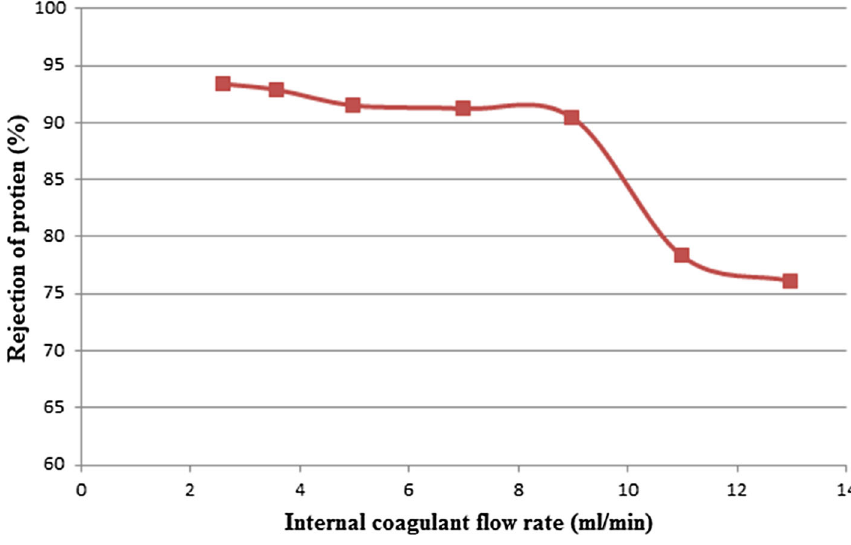
Fig. 11 Effect of various ICFR on protein rejection of the